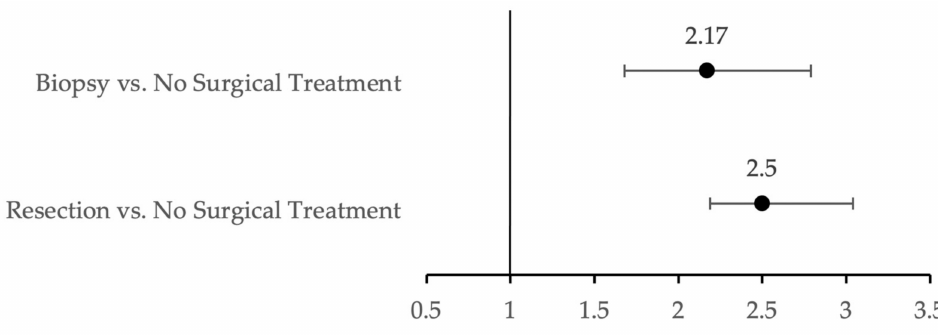
Figure 2. First-line treatment associated with increased MHD incidence post-LGG diagnosis using unadjusted odds ratios with 95% Wald confidence